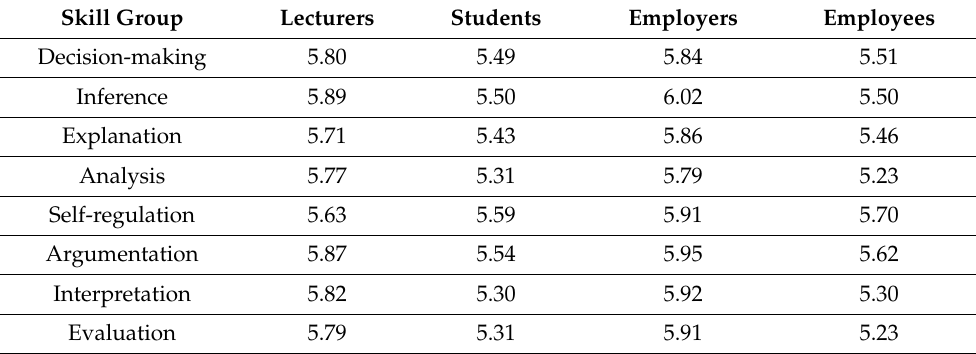
Table 5. Comparison of evaluation of the importance of critical thinking skills in the modern labour market (arithmetic mean (M), where 1 is ‘not important at all’ and 7 is ‘very important’). Skill Group Lecturers Students Employers Employees Decision-making 5.80 5.49 5.84 5.51 Inference 5.89 5.50 6.02 5.50 Explanation 5.71 5.43 5.86 5.46 Analysis 5.77 Self-regulation 5.63 Argumentation 5.87 5.54 Interpretation 5.82 5.30 5.92 5.30 Evaluation 5.79 5.31 5.91